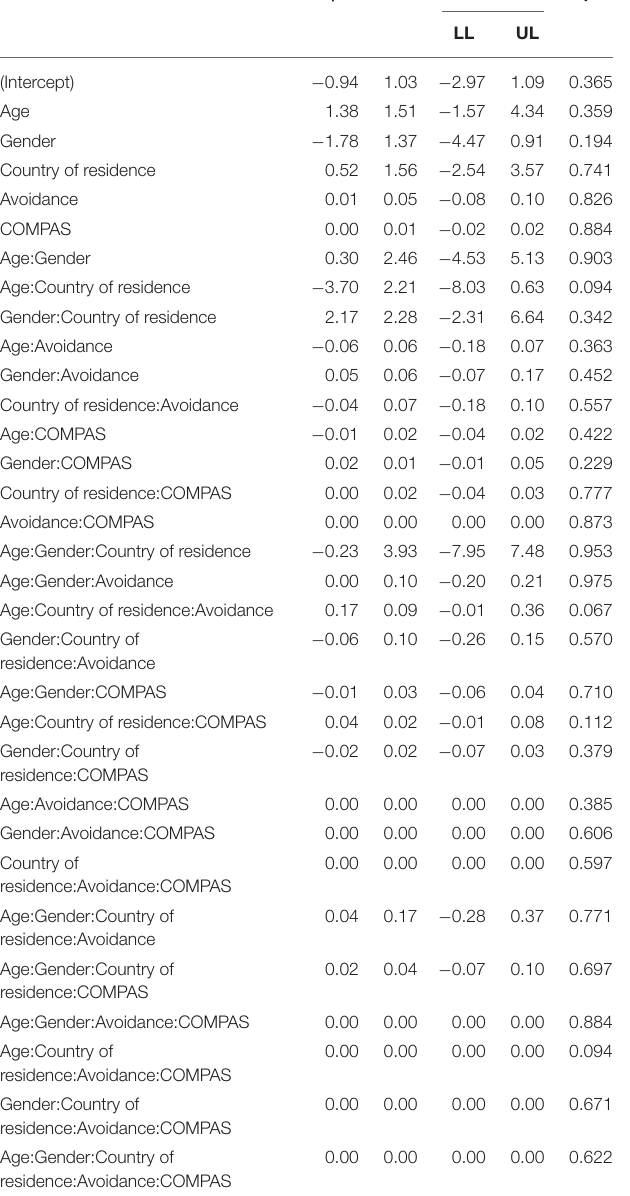
TABLE 2 | Omnibus regression analysis with avoidance coping. Effects